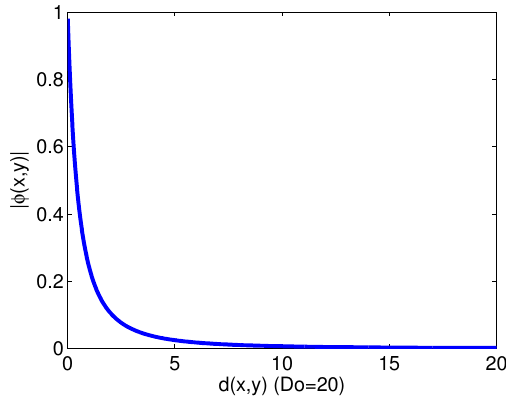
Figure 2. Magnitude of the function φ ( q , N m ) with distance from a neighbor